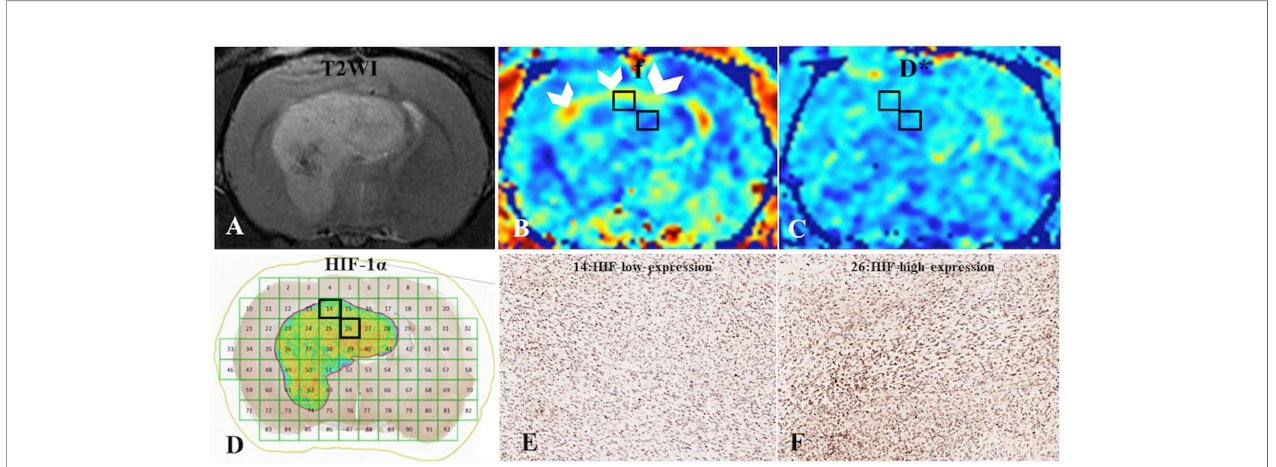
FIGURE 2 | (A) C6-cell glioma tissue was observed in a T2WI image. (B, C) f and D* maps. (D) ROI locations in the tumor area correspond to 14 and 26 (HIF-1 a map), for which the f values were 59% and 47%, respectively; the D* values were 341.69 ×10-6 mm2/s and 281.41 ×10-6 mm2/s, respectively; and the HIF-scores were 122.89 and 174.12, respectively. A high f value was found for the peripheral intratumoral tissue (white arrow). (E, F) Immunohistochemical staining images (× 400) showed low and high expression of HIF-1 a in the tumor for ROIs 14 and 26, respectively, on the HIF-1 a map.